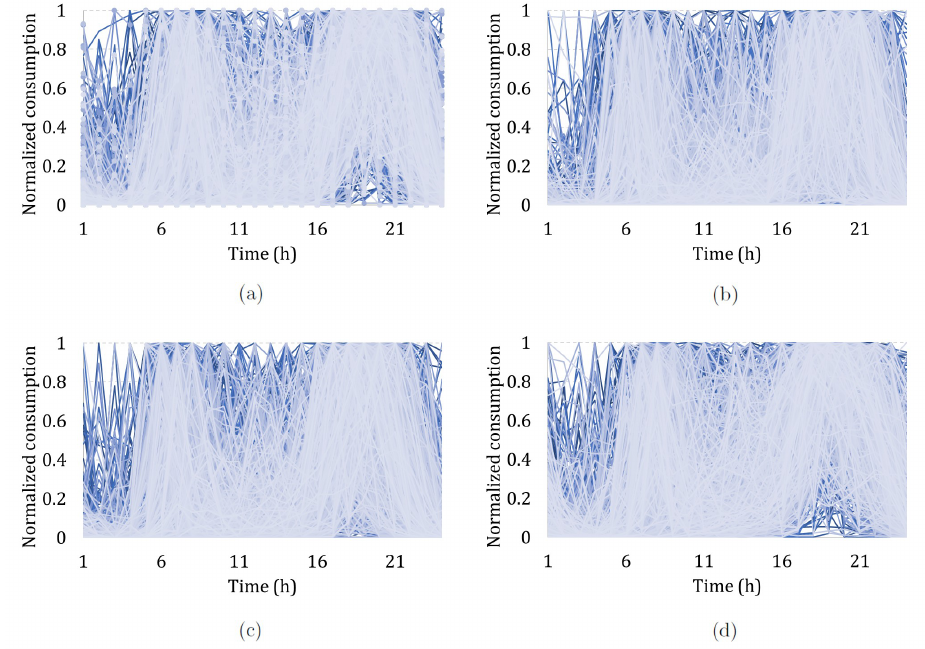
Figure 6. Consumers’ normalized consumption profiles for: ( a ) spring; ( b ) summer; ( c ) autumn; and ( d )